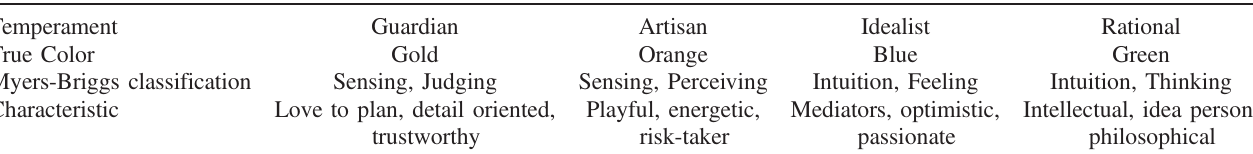
TABLE I. The four personality types.